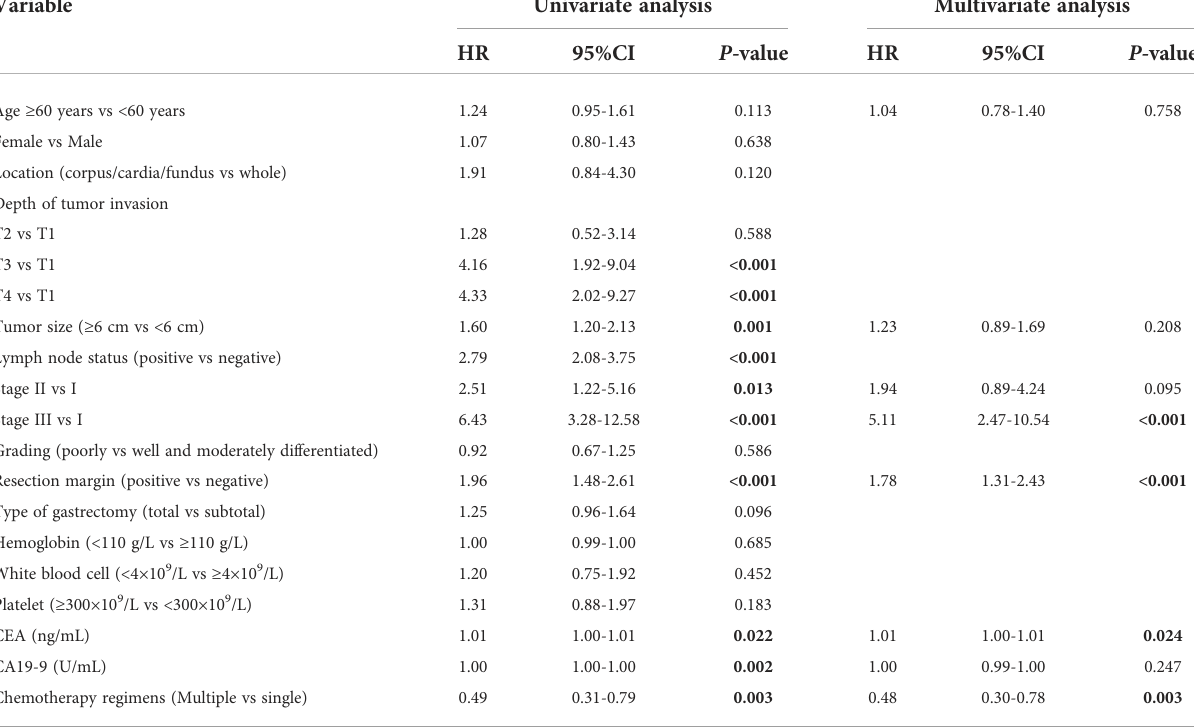
TABLE 2 Univariate and multivariate analyses of patients with gastric cancer (training cohort, N = 426).